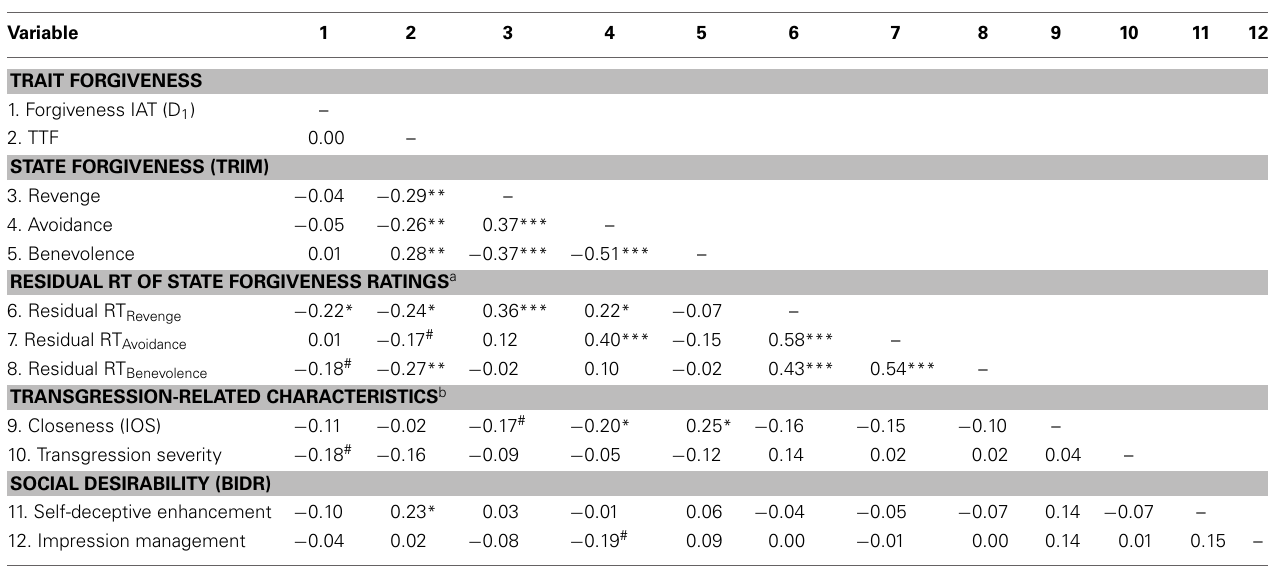
Table 3 | Intercorrelations Among Study Variables.